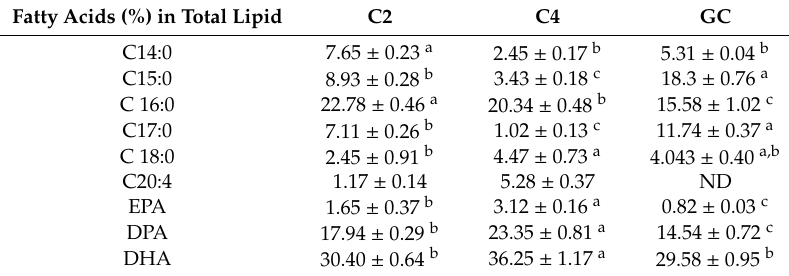
Table 4. Fatty acid composition (wt% of total fatty acids) of Aurantiochytrium sp. T66 cultivated on 40 g / L of acetic acid (C2) or butyric acid (C4). Glucose (GC) was used as